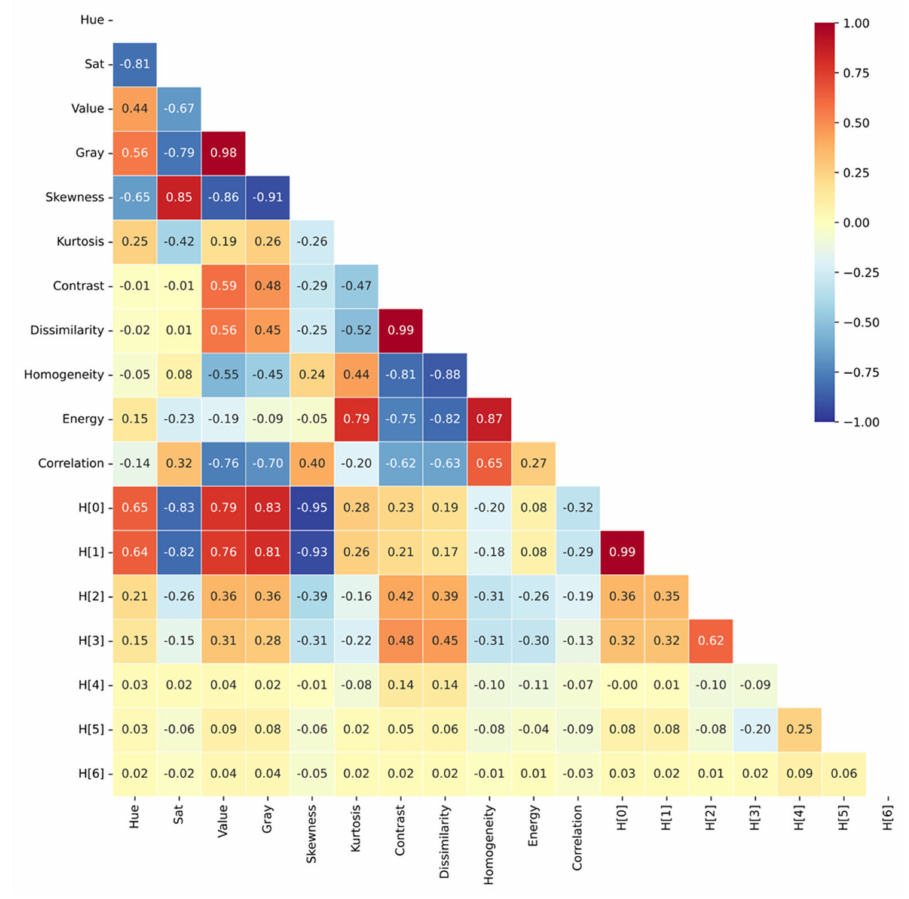
Figure 4. Correlation matrix of color, texture, shape features extracted from soil surface images.